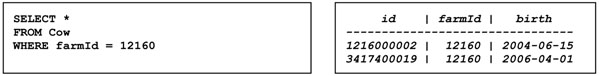
Query to get all columns and some rows of the Cow table